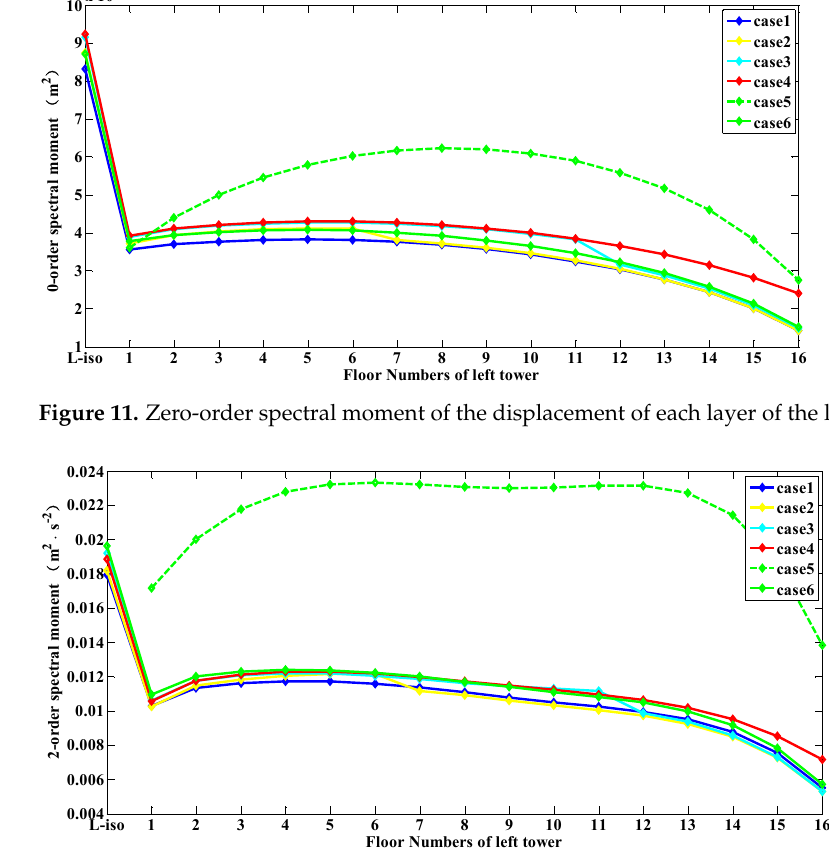
Figure 12. Second-order spectral moment of the displacement of each layer of the left tower.